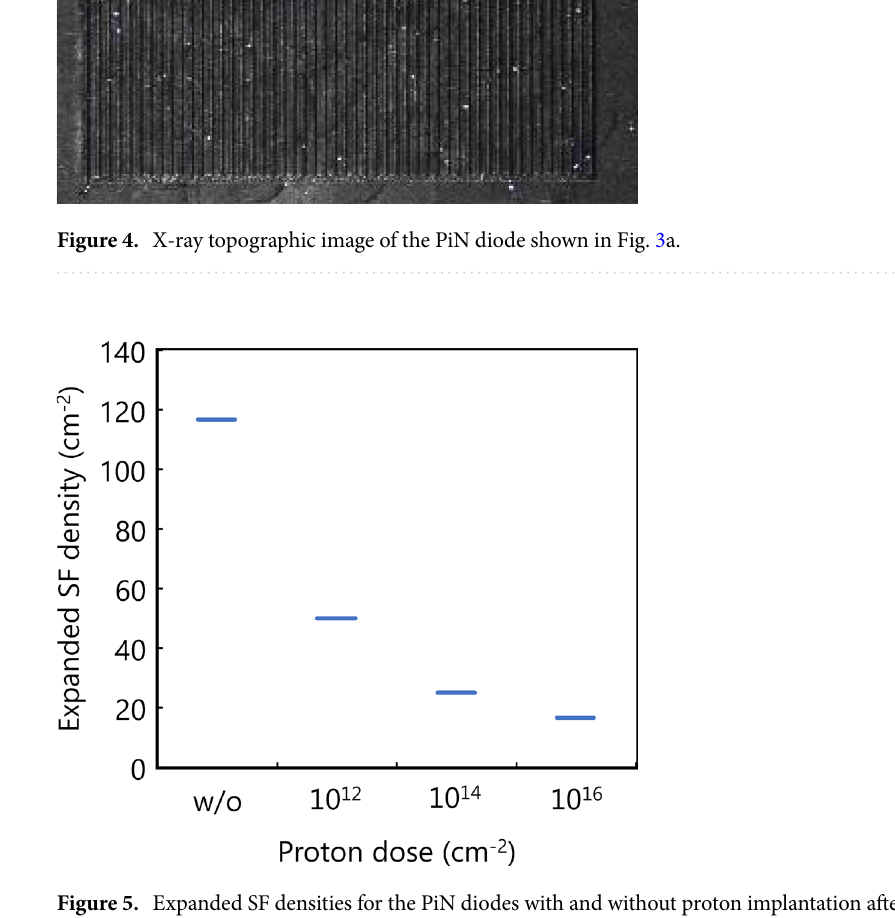
Figure 5. Expanded SF densities for the PiN diodes with and without proton implantation after the pulsed- current stress (each condition includes three stressed